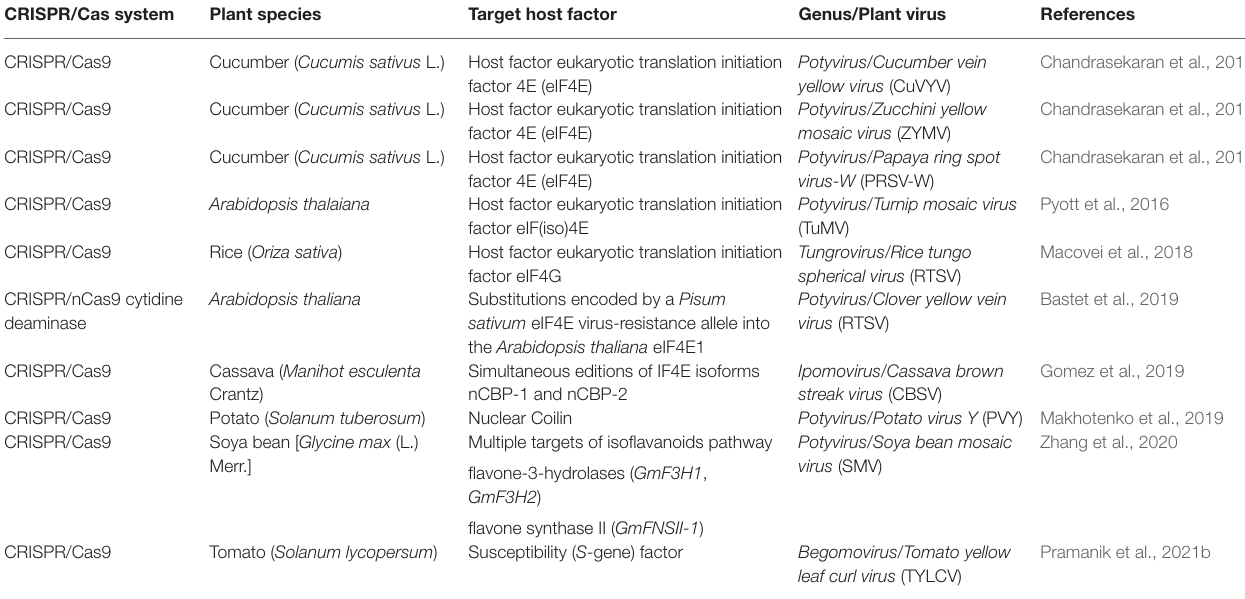
TABLE 1 | Summary of CRISPR/Cas system mediating resistance to plant virus by targeting host